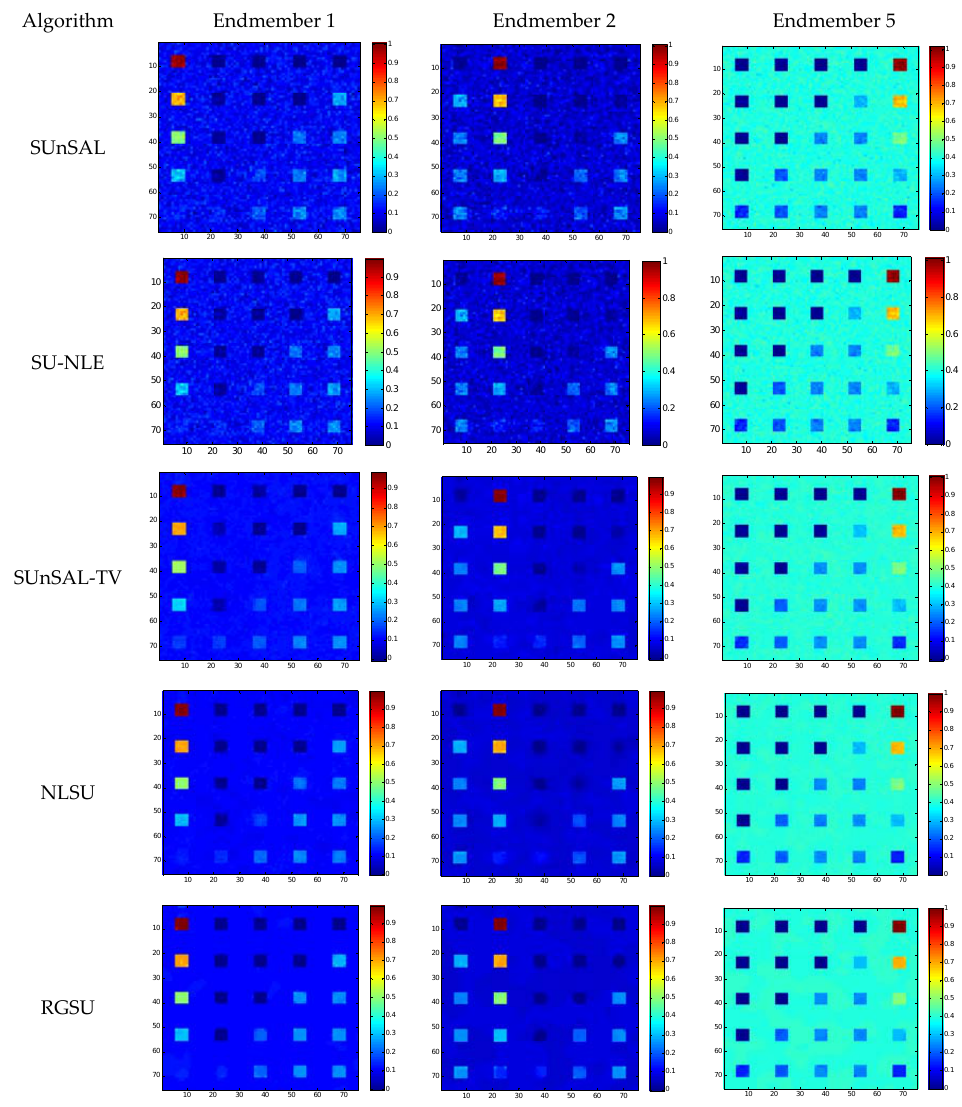
Figure 7. Estimated abundances of endmembers 1, 2, and 5 for simulated dataset 1.